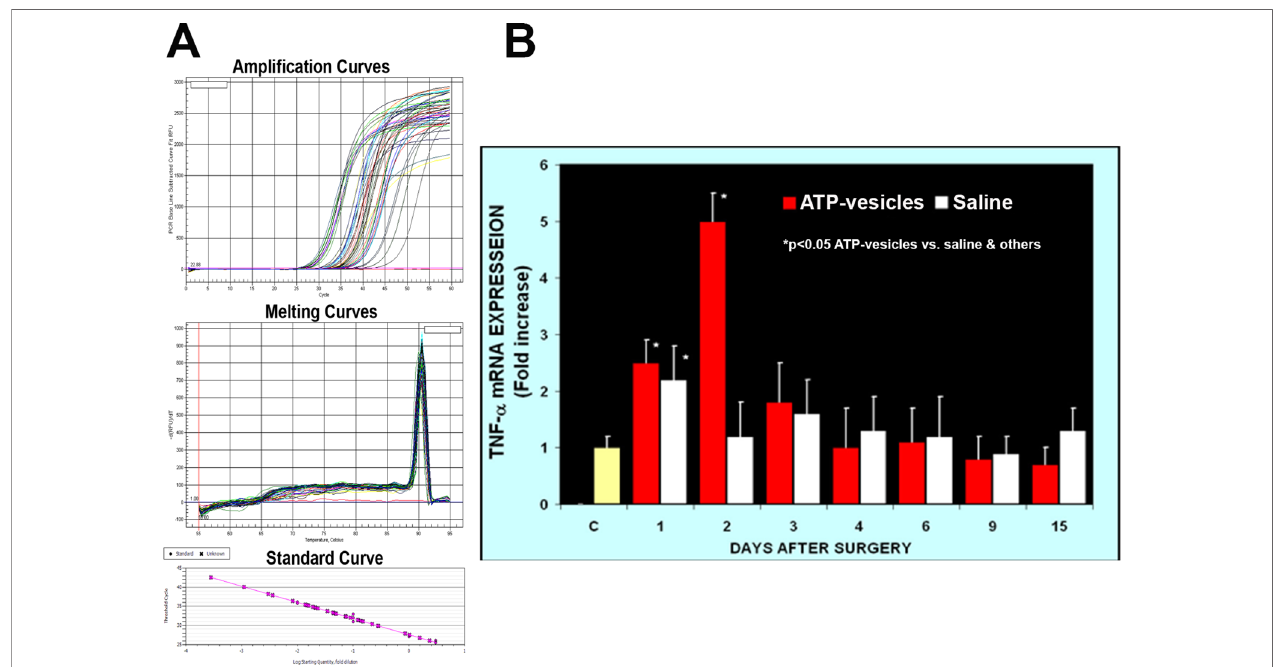
FIGURE 3 | Real-time PCR comparison of TNF- a expression in wound tissues of ATP-vesicle – treated (study) and the saline-treated (control) groups. (A) represents the ampli fi cation curves, melting curves, and standard curve of real-time PCR and (B) shows their quantitative fold changes indicating 4-time higher expression at day 2 by ATP-vesicles. Data shown are the mean ± SD of four to six different wound tissues, with triplicate assays for each sample. Normal rabbit ear skin was used as baseline control (C). *Signi fi cantly different when compared with the saline-treated control group and the baseline control, p <